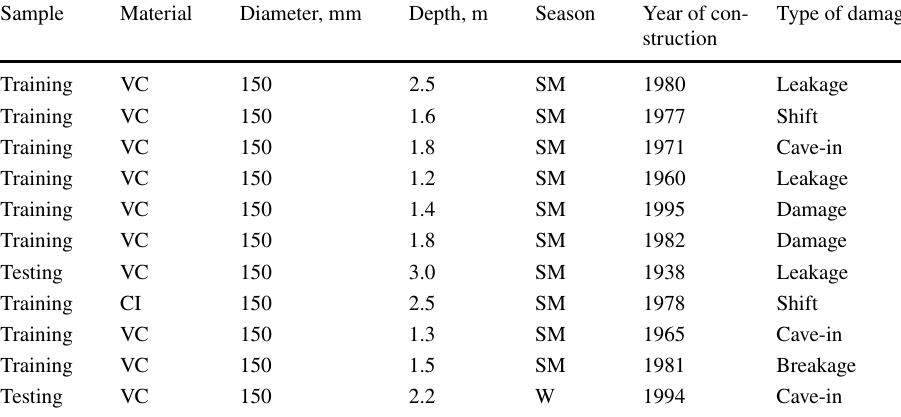
Table 8 Exemplary